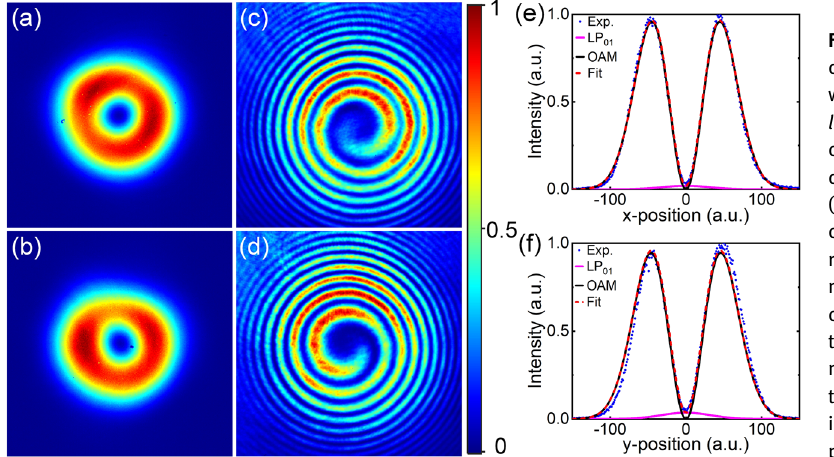
front. The blue dots in Figure 6(e) and (f) show the measured one-dimensional intensity distributions across the center of the beams shown in Figure 6(a) and (b) along the x -position and y -position, respectively. It is clear that there is some low level residual intensity at the center of the beam which we believe to be due to ampli fi ed spontaneous emission (ASE) within the fundamental LP mode. The 01 measured intensity pro fi les can be fi tted well with inco- herent intensity superposition of the fundamental Gaussian mode (LG ) and the fi rst-order ( | l | = 1) OAM mode 00 (namely the fi rst higher-order Laguerre – Gaussian mode (LG ) in free-space, represented by the red short-dash 01